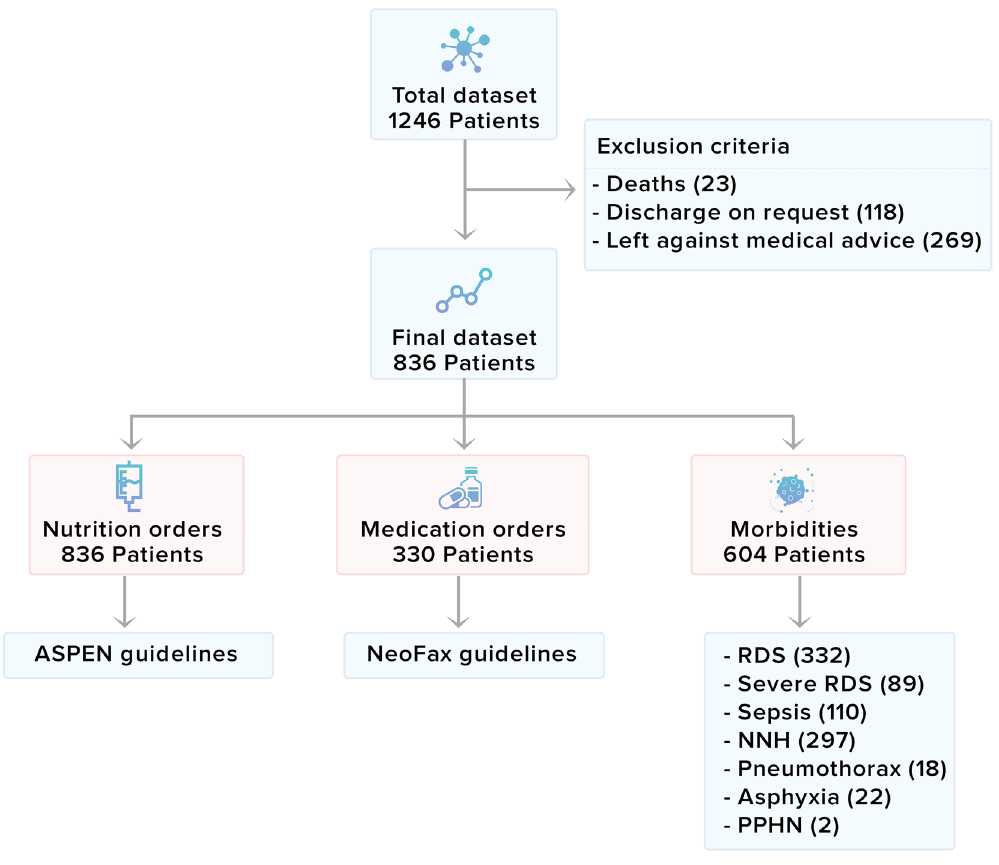
Figure 2. Study design for predicting length of stay using nutrition orders, medication orders, and incidence of clinical diagnosis during stay in